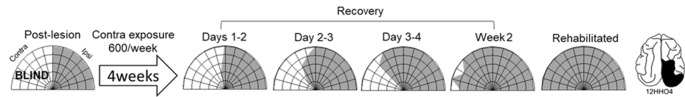
Visual responsiveness recovered in a central-to-peripheral pattern. A hemianopic animal remained blind in contralesional space after 4 weeks of exposure sessions (600 auditory-visual exposures/session). Contralesional visual responses were first observed in the 5th week at 15°. The effective region expanded to 45° within several days (Day 0 was a day of exposure, and the results depicted were averaged over 2 days), and to at all contralesional locations tested within 2 weeks.